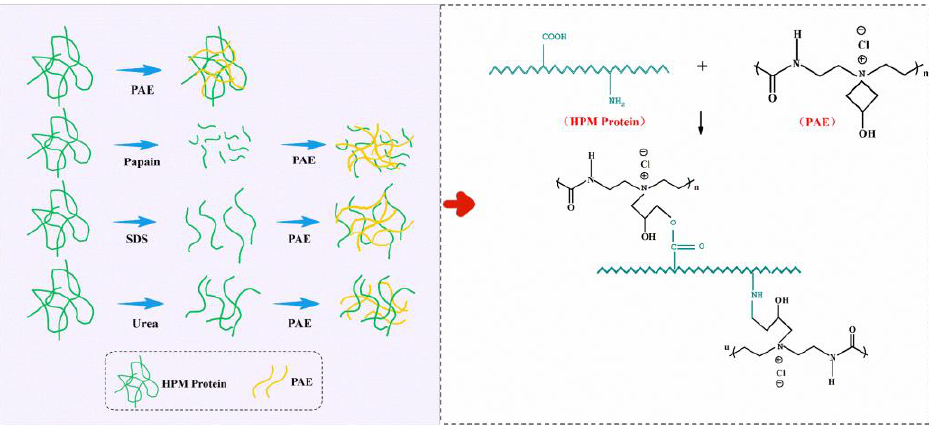
Figure 2. The denaturation and crosslinking mechanism of HPMP